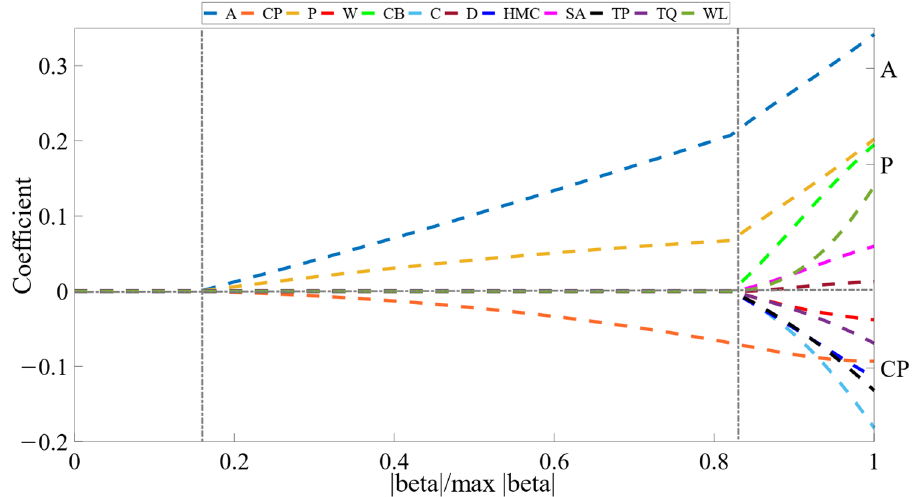
Figure 6. Lasso fitting coefficient tracer diagram as α takes 0.1.